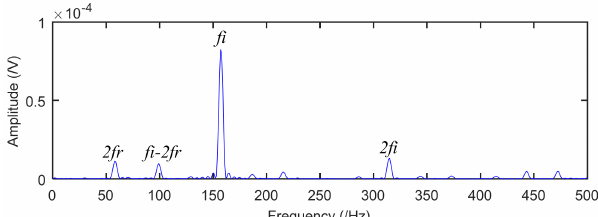
Figure 19. The frequency spectrum after noise reduction using smooth orthogonal decomposition.